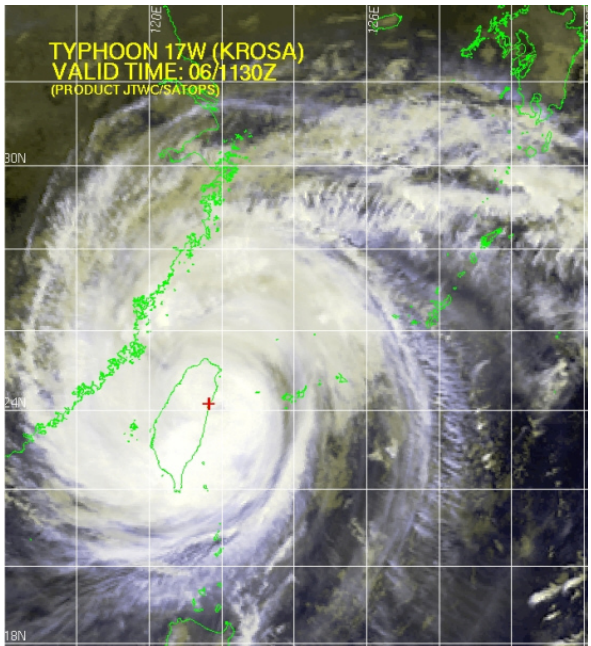
Figure 1. Typhoon Krosa made landfall on Taiwan Fig. 1. Typhoon Krosa made landfall on Taiwan.